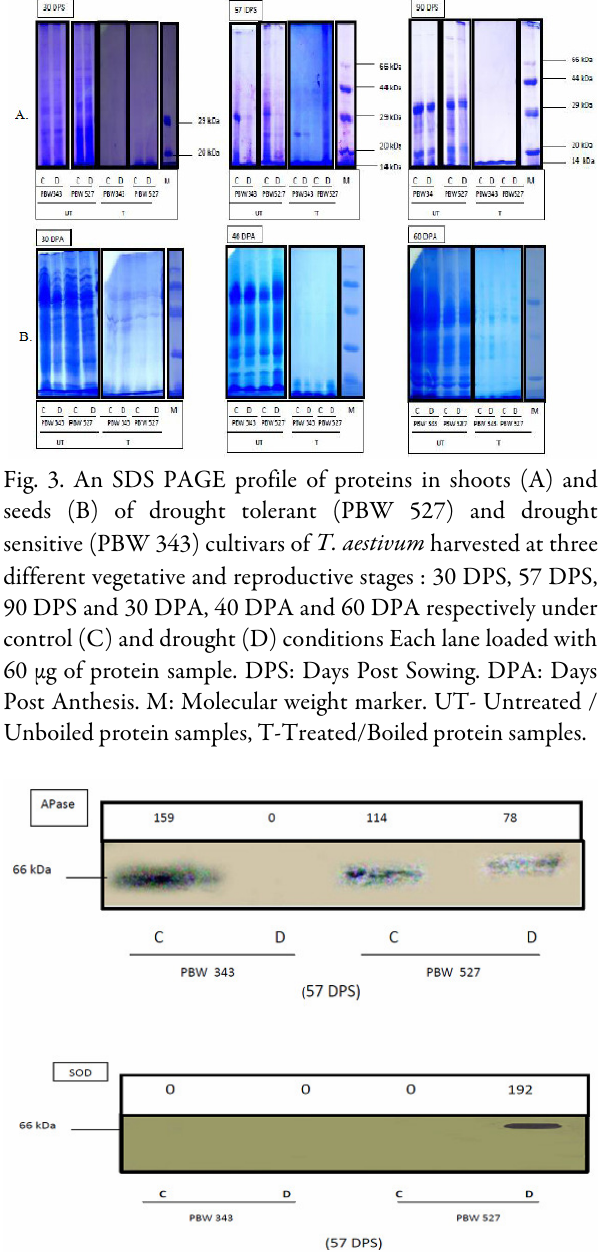
Fig. 4: Immuno-blot analysis of boiling soluble proteins in shoots of drought tolerant (‘PBW 527 ʼ ) and drought sensitive (‘PBW 343 ʼ ) cultivars of T. aestivum at three different stages (30, 57, 90 DPS) under control (C) and drought (D) conditions. Numerical values as shown in the top of panels indicates relative band intensities which were determined using Gel visualisation, Documentation and Analysis system (Bio –